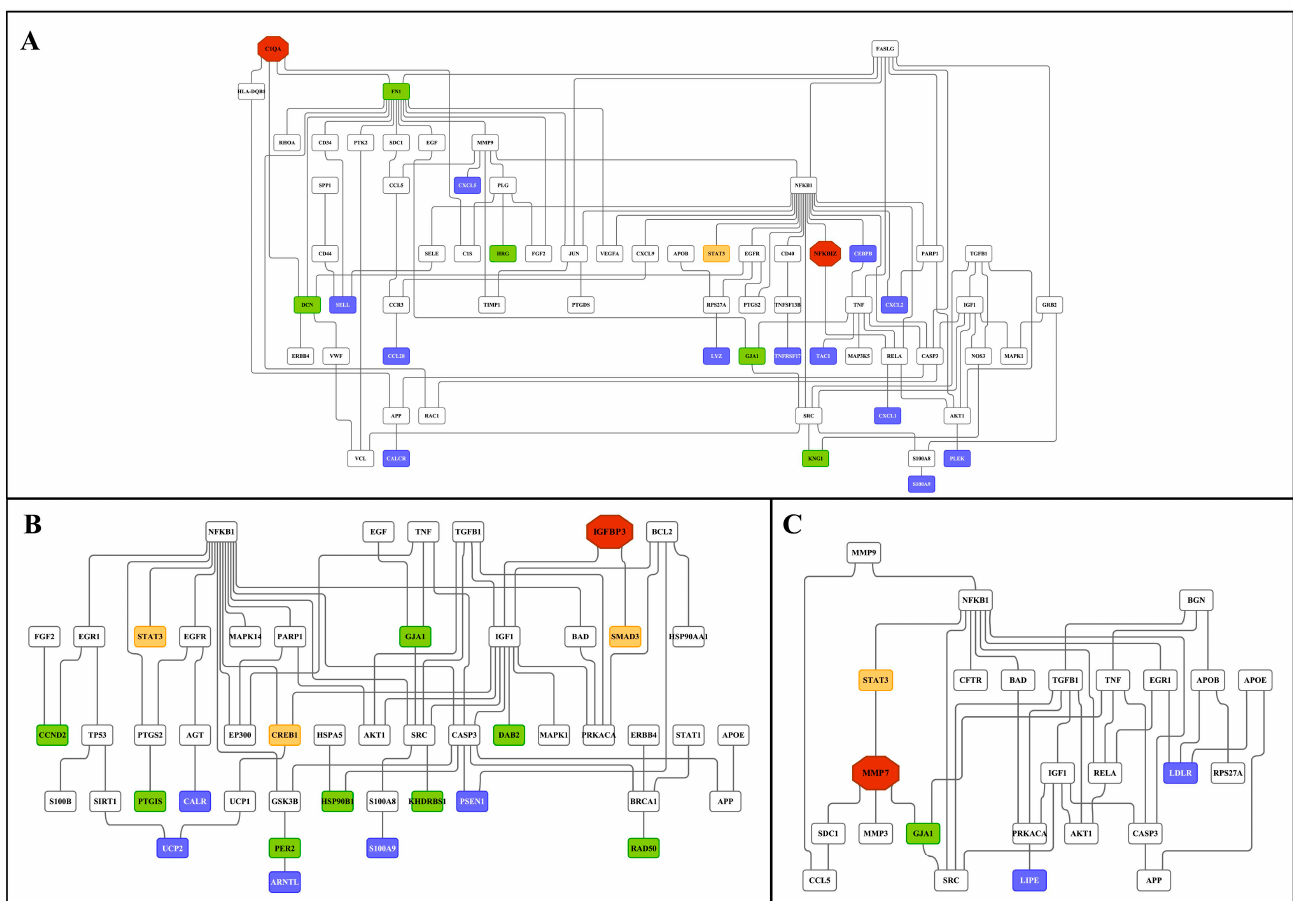
Figure 11. Master regulatory gene networks in the kidney of high-dose diclofenac-treated animals. Based on interaction information available in the GeneWays database, the master regulatory gene networks were constructed and fused using the GeneXplain platform. The red, violet, green, white and yellow nodes represent genes coding for master regulators, up-, down-regulated DEGs, connecting genes and enriched transcription factors, respectively. Panel A: Master regulatory network of immune and inflammatory response genes. Panel B: Master regulatory network of cellular stress and apoptosis-regulated genes. Panel C : Master regulatory network of genes involved in metabolic processes.